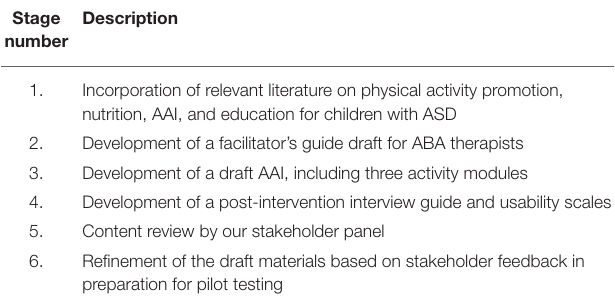
TABLE 1 | Stages of CAAN Development. TABLE 2 | Specific Benefits and Impact of Stakeholder Engagement on the CAAN